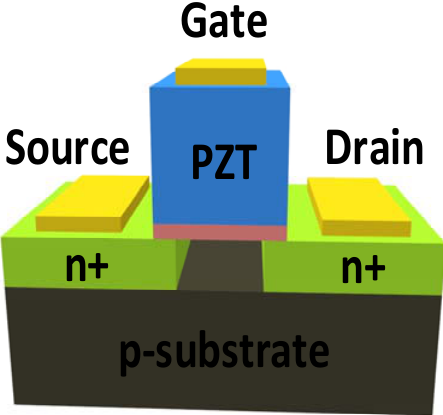
Figure 16. Schematic of a ferroelectric (FE) field effect transistor (FET).